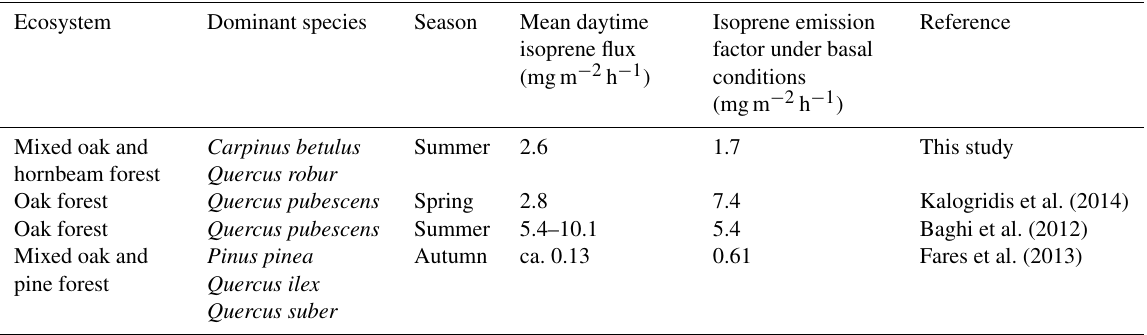
Table 4. Non-exhaustive summary of isoprene fluxes recorded in the Mediterranean region and the isoprene emission factor under basal conditions (temperature: 30 ◦ C and PAR: 1000µmolm − 2 s − 1 ) .